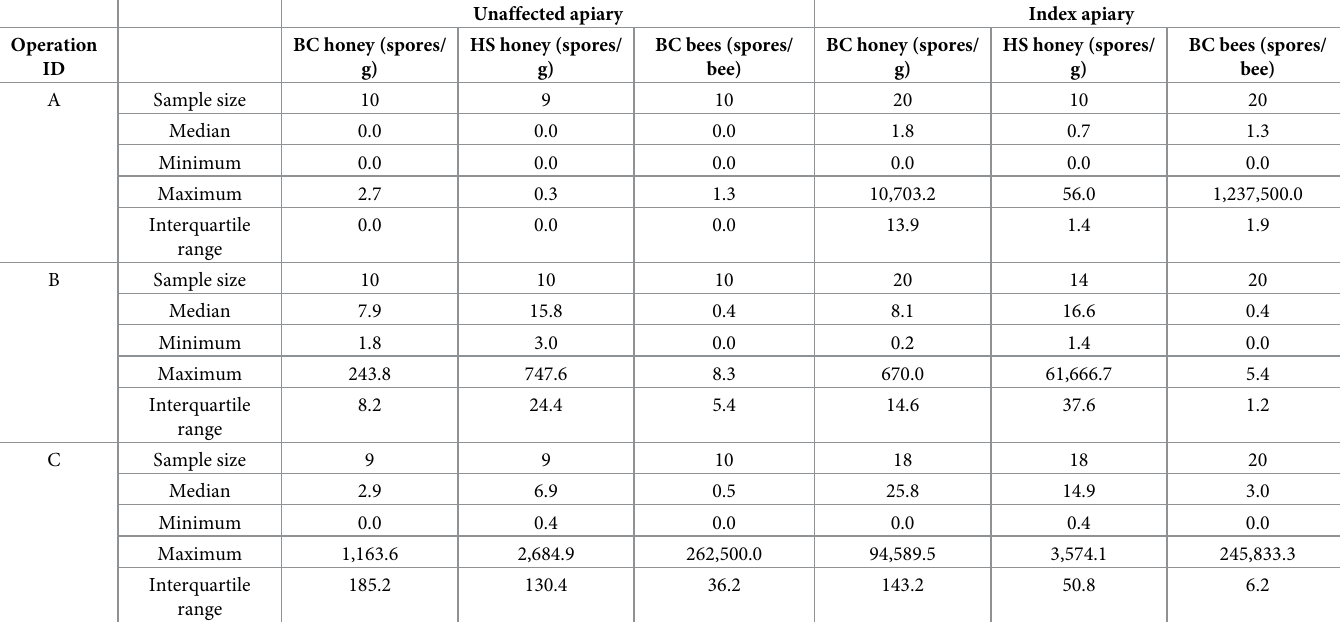
Table 1. Summary statistics of concentrations of Paenibacillus larvae spores from individual hives.